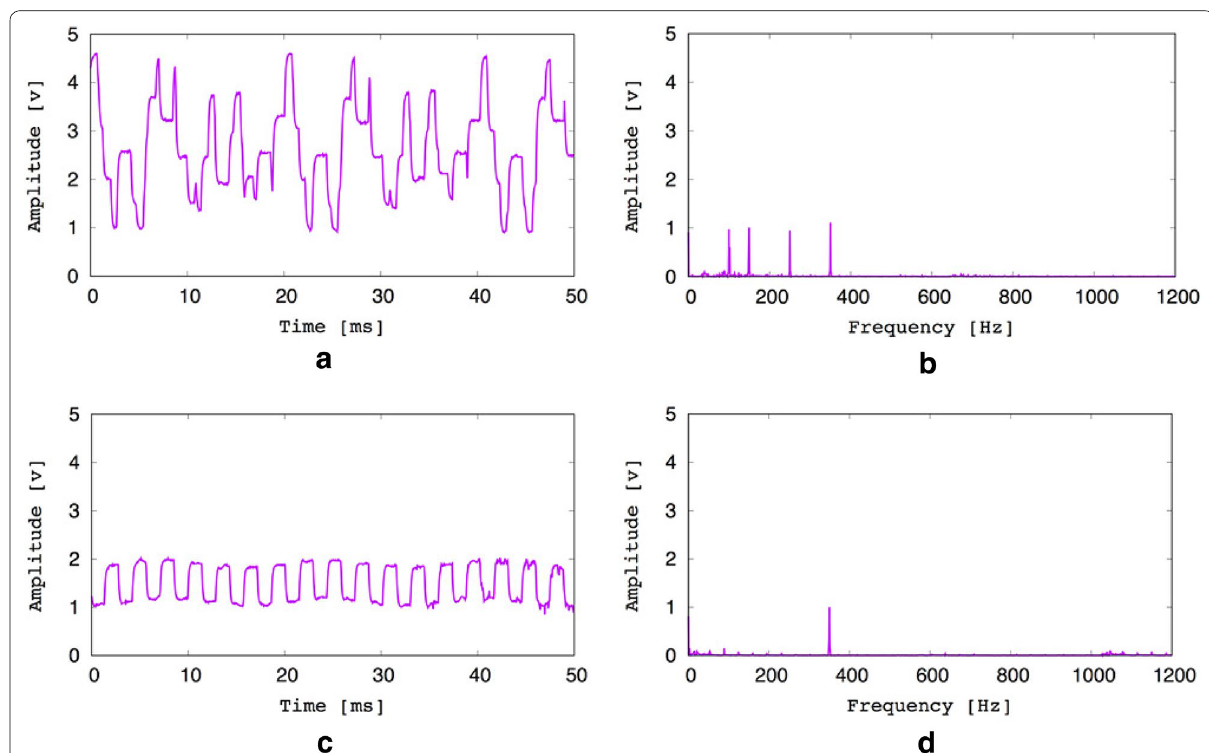
Fig. 5 Received signals in the time and frequency domains. a , c Signals in the time domain from the unique ID encoding emitter and repeated ID encoding emitter, respectively; b , d signals in the frequency domain from the unique ID and repeated ID encoding emitters,